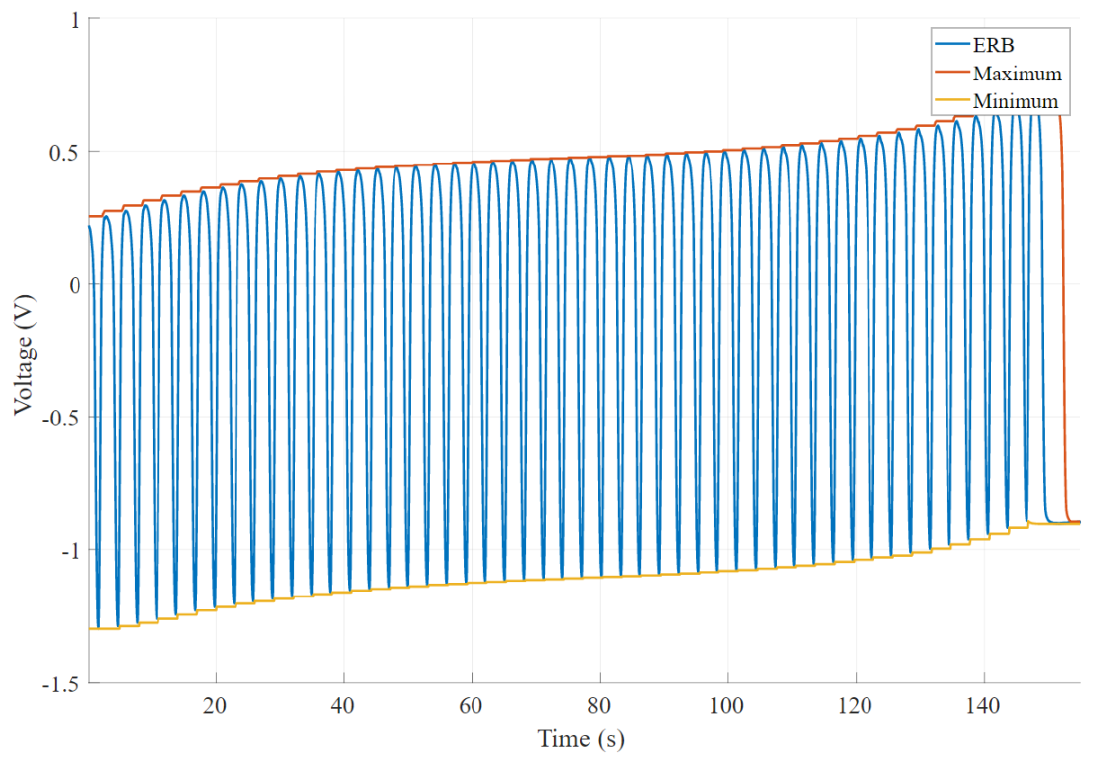
Figure 9. An example output shows a consistent amplitude. The graph shows considerable baseline changes; however, it does not affect the amplitude of the